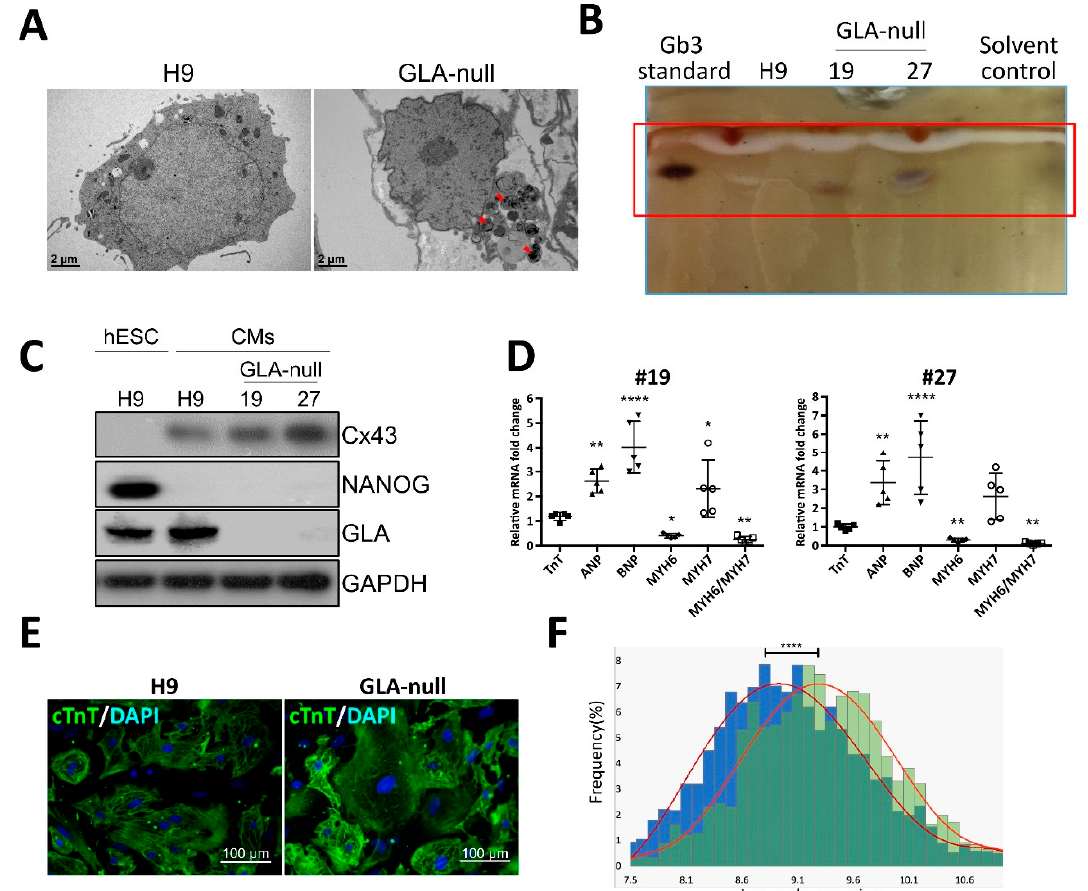
Figure 3. Recapitulation of FD-specific cardiac abnormalities in GLA-null cardiomyocytes. ( A ) TEM images showing the ultrastructure of parental type (H9) and GLA-null CMs. The red arrowheads indicate the multilayered lysosomal structure. ( B ) Gb3 content in parental (H9) and GLA-null CMs (clones #19 and #27) analyzed by TLC. ( C ) Western blot showing lack of expression of GLA in clones #19 and #27 of GLA-null CMs as compared to the parental wild type CMs and hESCs (H9). Connexin 43 (Cx43) and NANOG served as cardiomyocyte and pluripotency markers, respectively. GAPDH used as a loading control. ( D ) qRT-PCR analysis of expression several fetal heart markers in CM clones #19 and #27. The results are expressed as fold change relative to H9 CMs. ( E ) Immunostaining of cTnT showing significantly enlarged size of GLA-null CMs compared to H9 CMs. ( F ) Quantification of area size of GLA-null CMs (green columns) and H9 CMs (blue columns). At least 200 cells were analyzed individually and statistical difference is p < 0.001.